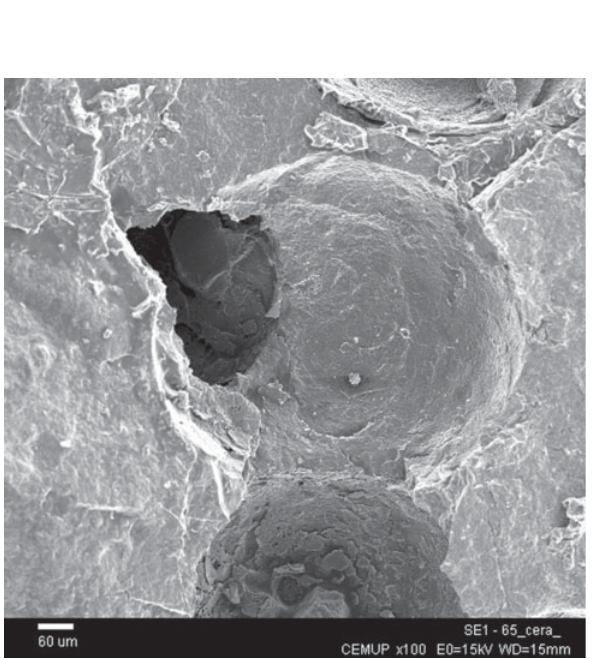
Figure 4. SEM picuture of porous GR-HA specimen with 65 vol% porosity.